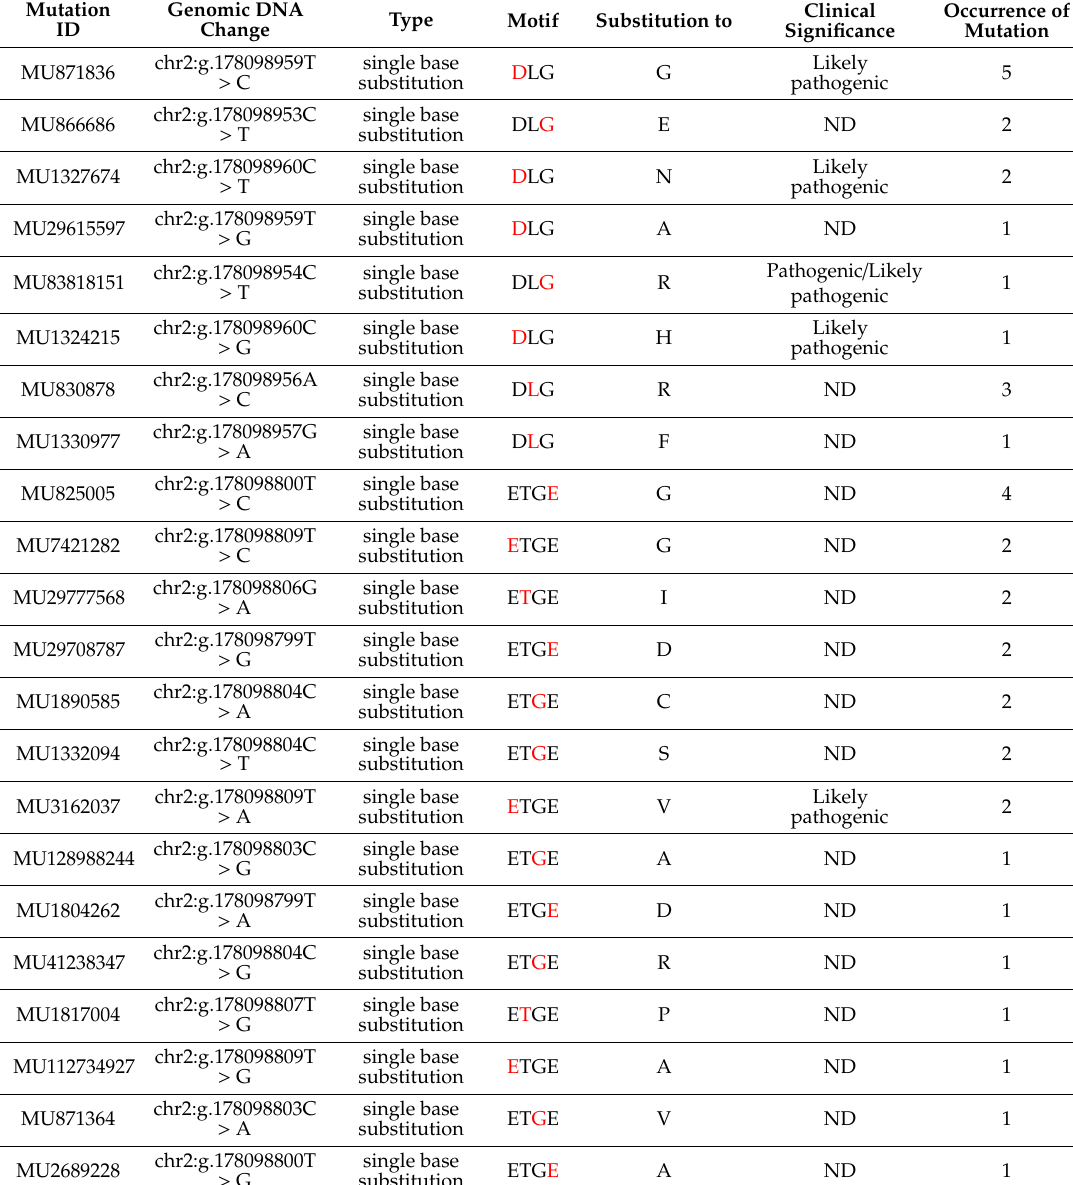
Table 1. NF-E2-related factor 2 (NRF2) mutations found in NRF2-ECH homology 2 (Neh2) domain ETGE and DLG motif of hepatocellular carcinoma (HCC) patients (International Cancer Genome Consortium (ICGC)